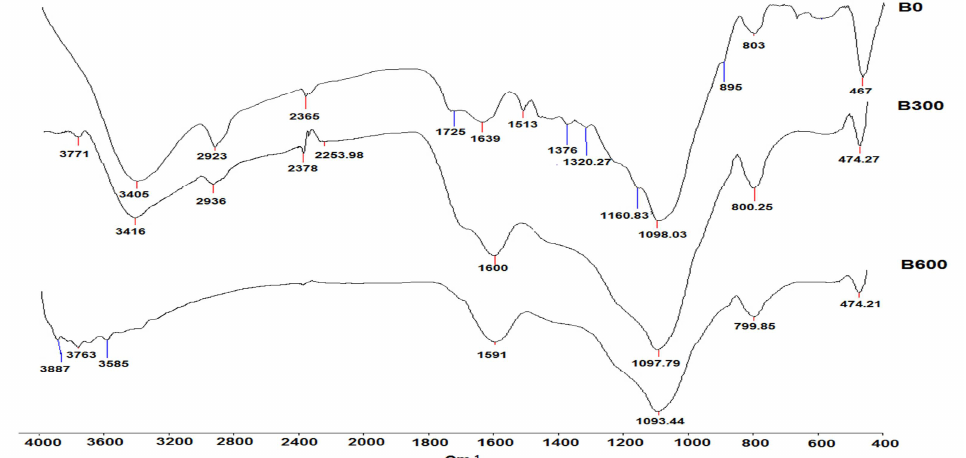
Figure 1. FTIR spectra of rice husk before (B0) and after pyrolysis (B300 and B600) [X-axis and Y-axis are wavenumber (cm -1 ) and transmittance